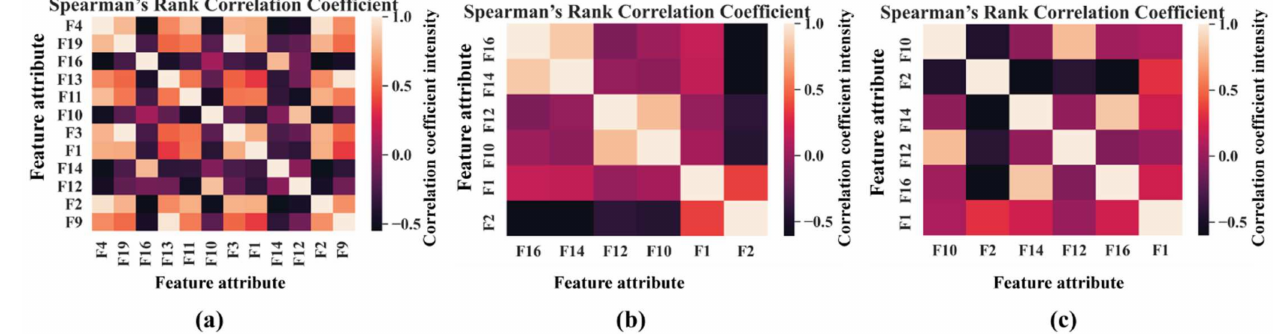
Figure 12. Representation of the feature correlation in the UFP of the three datasets: ( a ) UFP of dataset 1, ( b ) UFP of dataset 2, and ( c ) UFP of dataset 3.